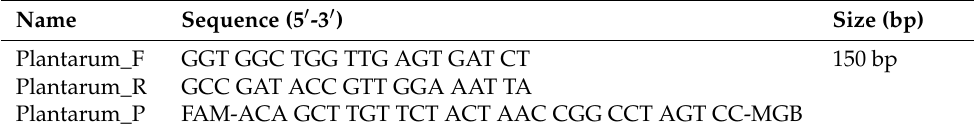
Table 2. Information for primer and probe for detecting L . plantarum subsp. plantarum